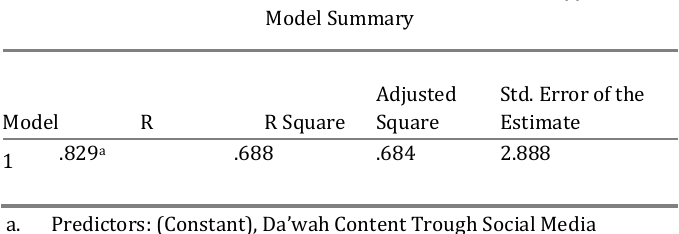
Table 7 Correlation Coefficient Calculation Results (r)